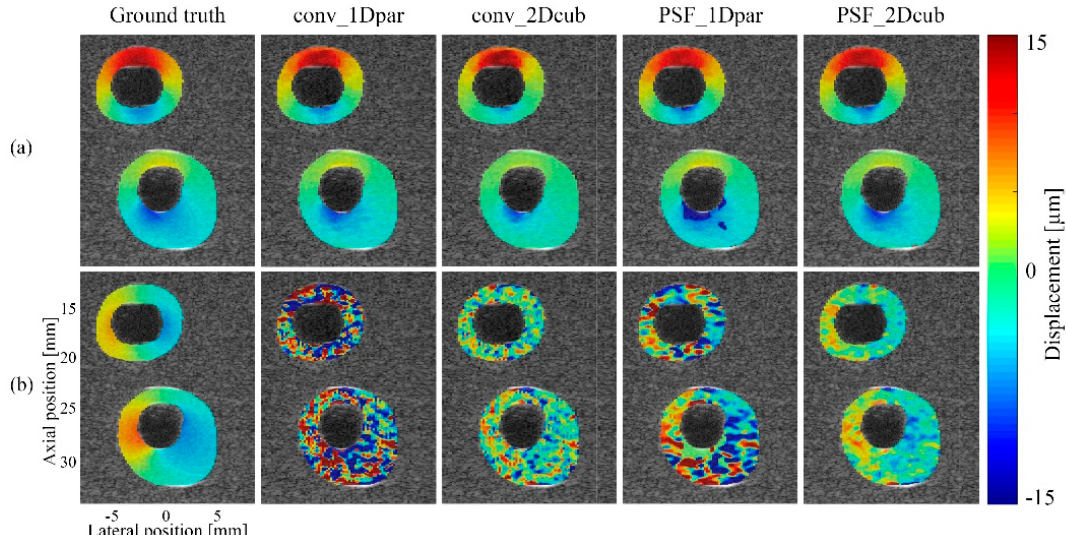
Figure 6. Axial ( a ) and lateral ( b ) inter-frame displacements for the carotid vessel phantom at diastole. The estimated displacements obtained using the four different methods are visualized together with the ground truth displacements derived from the finite element model (FEM) model.